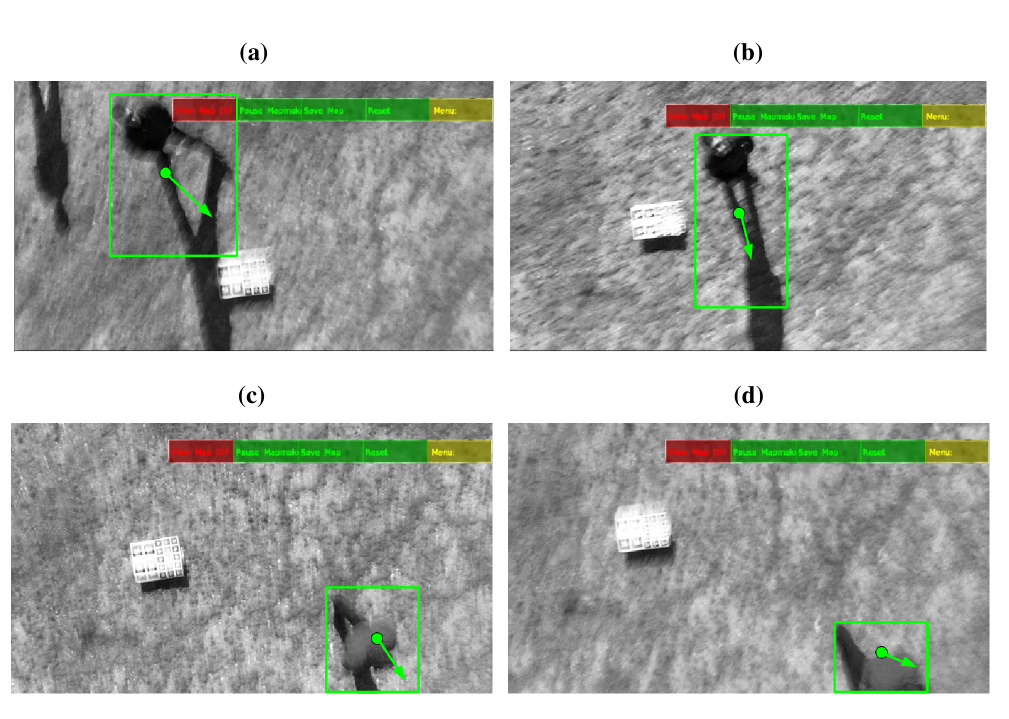
Figure 10. Example of detection and tracking of a single dynamic object. In (a),(b),(c) and (d) the dynamic object’s position and direction are highlighted as both the UAV and the person move in the